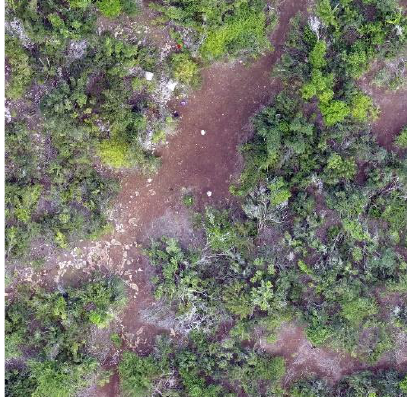
Figure 7: Close-up of the drone photography to show the exposed limestone, soil, dead trees, and green